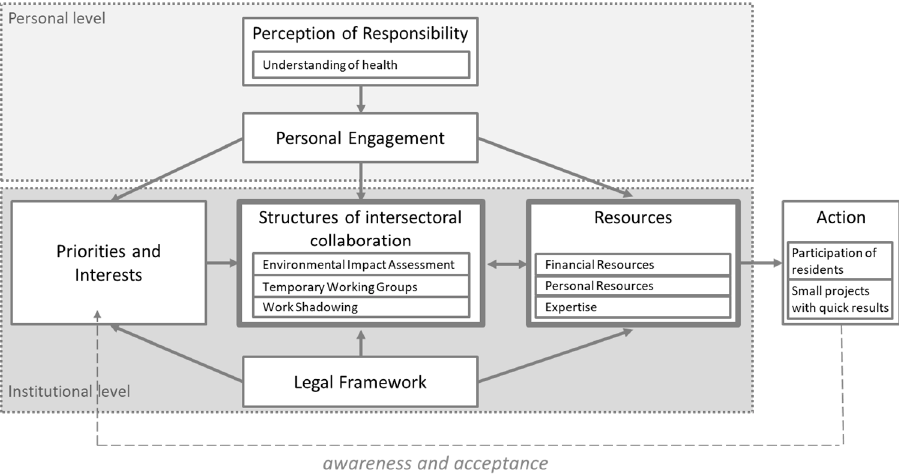
Figure 1. Levels of influence and interrelationships of its components on addressing the cross-cutting issue of active mobility promotion among elderly in the public health and planning sectors.